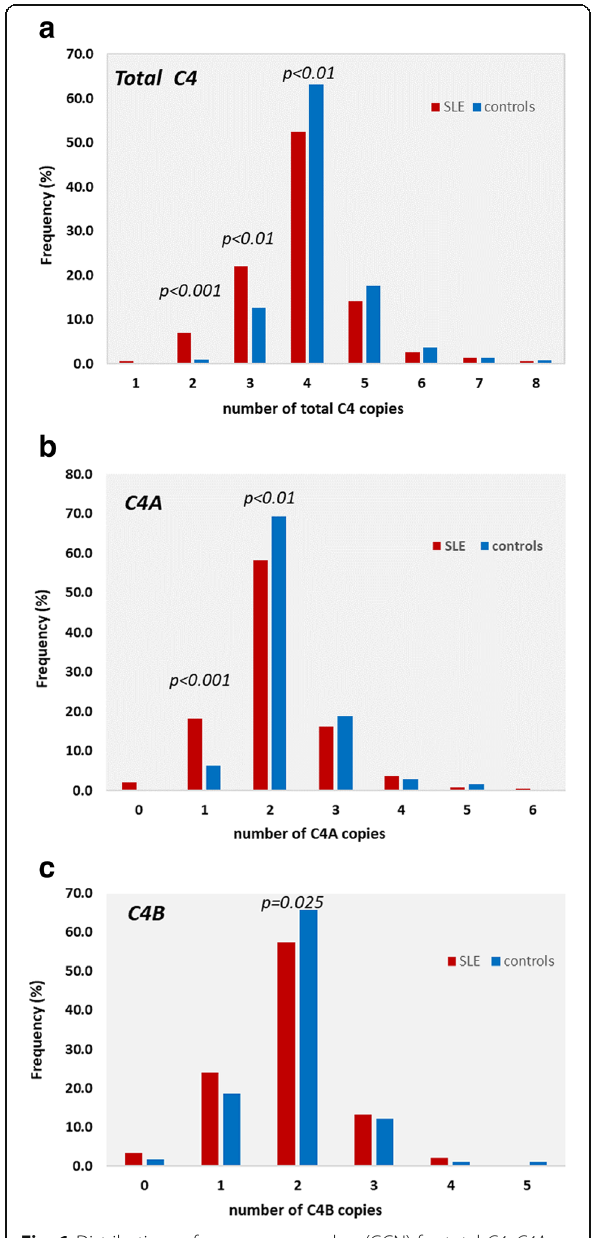
Fig. 1 Distributions of gene copy number (GCN) for total C4 , C4A and C4B in healthy controls and systemic lupus erythematosus patients. GCN for total C4 ( a ), C4A ( b ) and C4B ( c ) was determined in 427 patients with systemic lupus erythematosus (SLE) and 301 healthy controls by quantitative real time